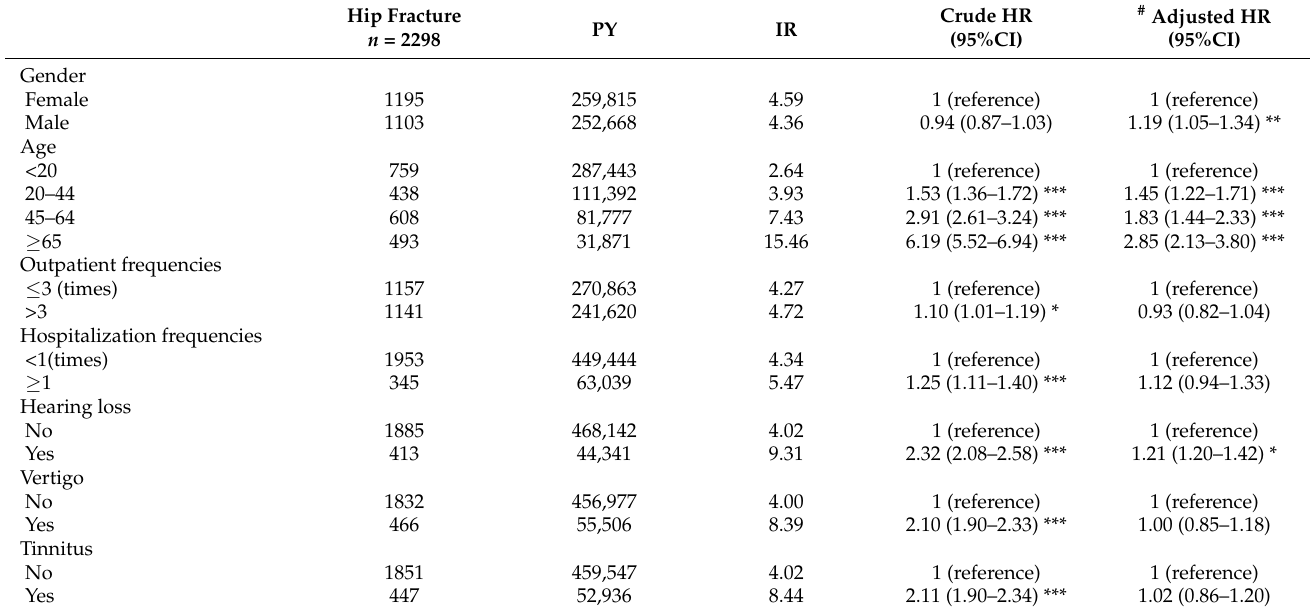
Table 4. The subgroup analysis risk of hip fractures among the COM